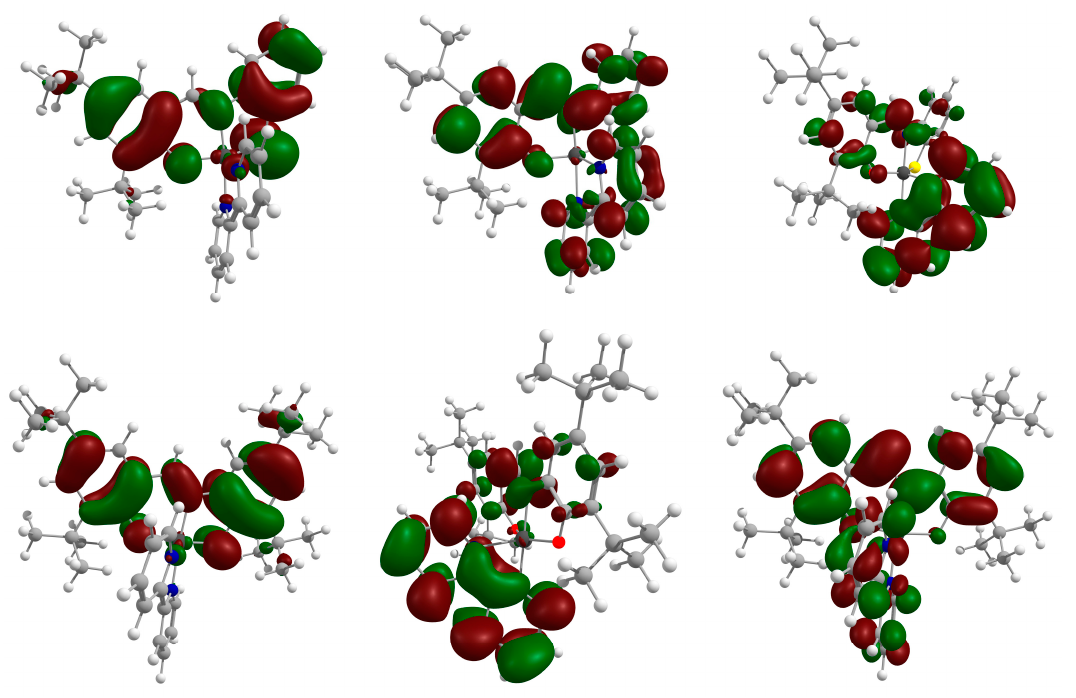
Figure 12. The isosurfaces of HOMO ( left ), LUMO+1 ( middle ) and LUMO+2 ( right ) orbitals for the optimized structures of 6 ( top ) and 8 ( bottom